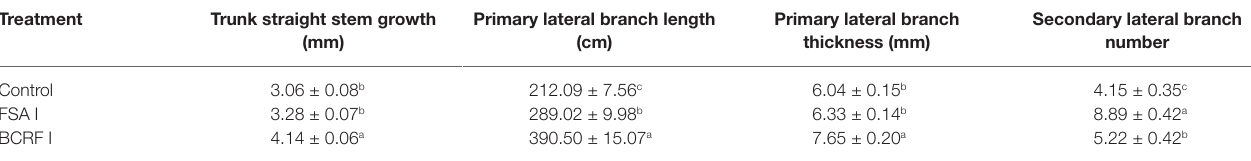
TABLE 2 | Aboveground biomass of peach trees under different treatments.